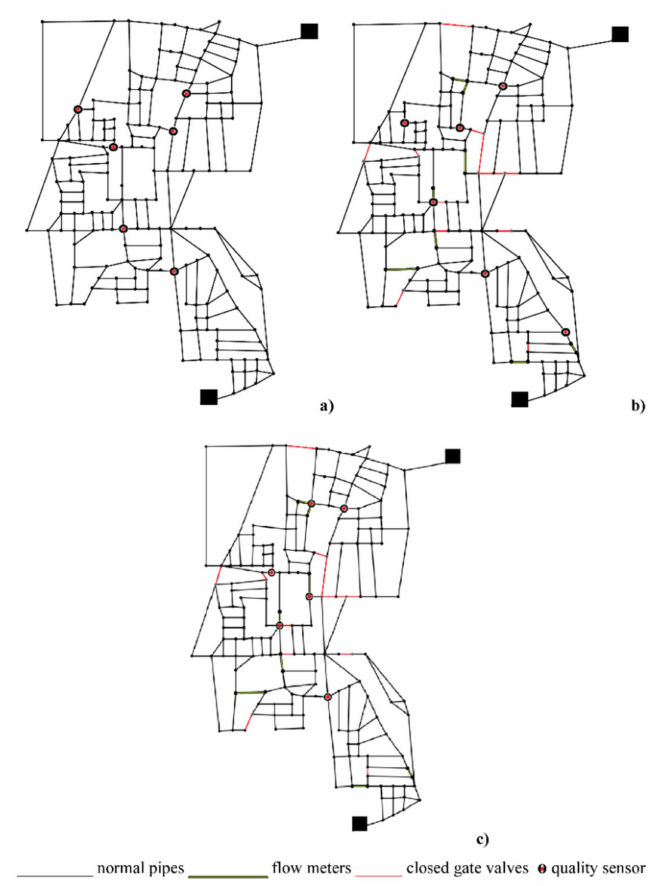
Figure 4. Optimal location of 6 sensors in ( a ) original un-partitioned WDN ( Var0Opt1 ), ( b ) partitioned WDN ( Var1Opt1 ), and ( c ) partitioned WDN ( Var1Opt4